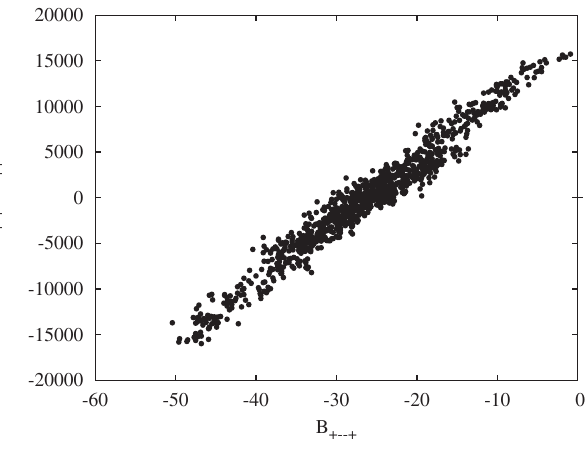
FIG. 7. B þ(cid:3)þ(cid:3) B þþ(cid:3)(cid:3) vs B þ(cid:3)(cid:3)þ for measurements of CESR BPM 33. There are 1024 turn-by-turn